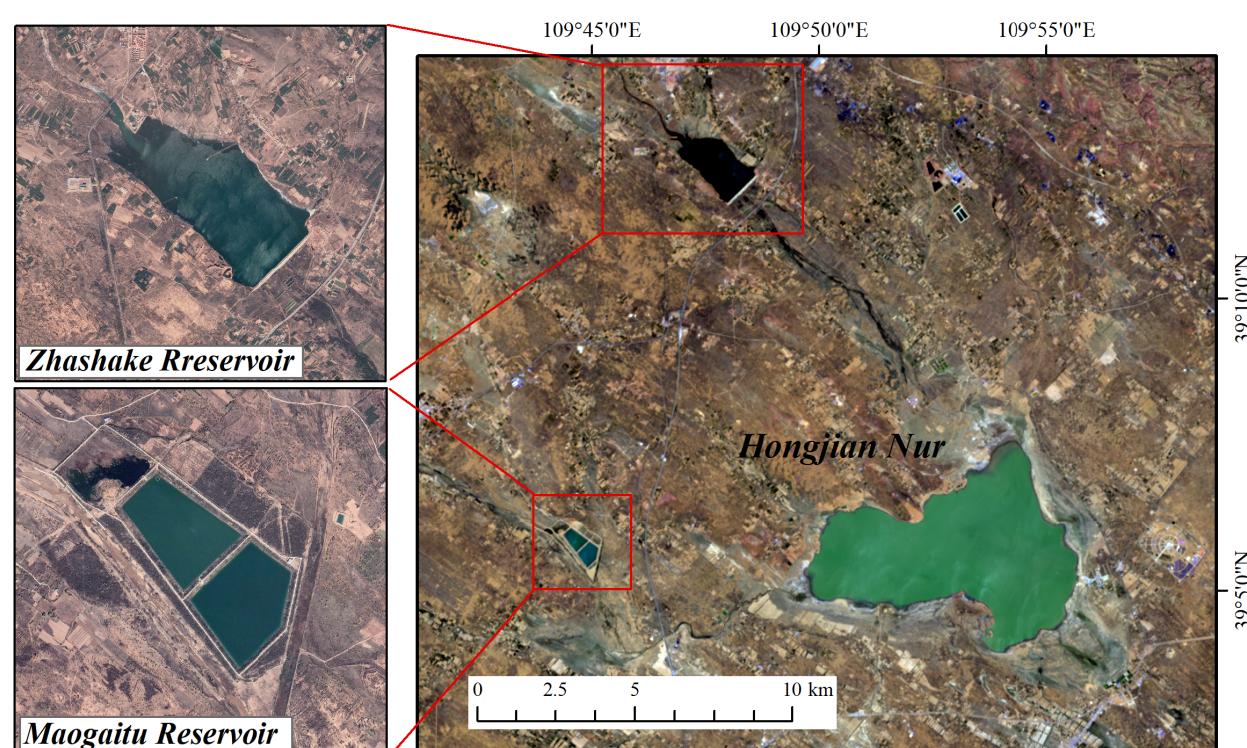
Figure 2. Locations of the Zhashake Reservoir and the Maogaitu Reservoir.